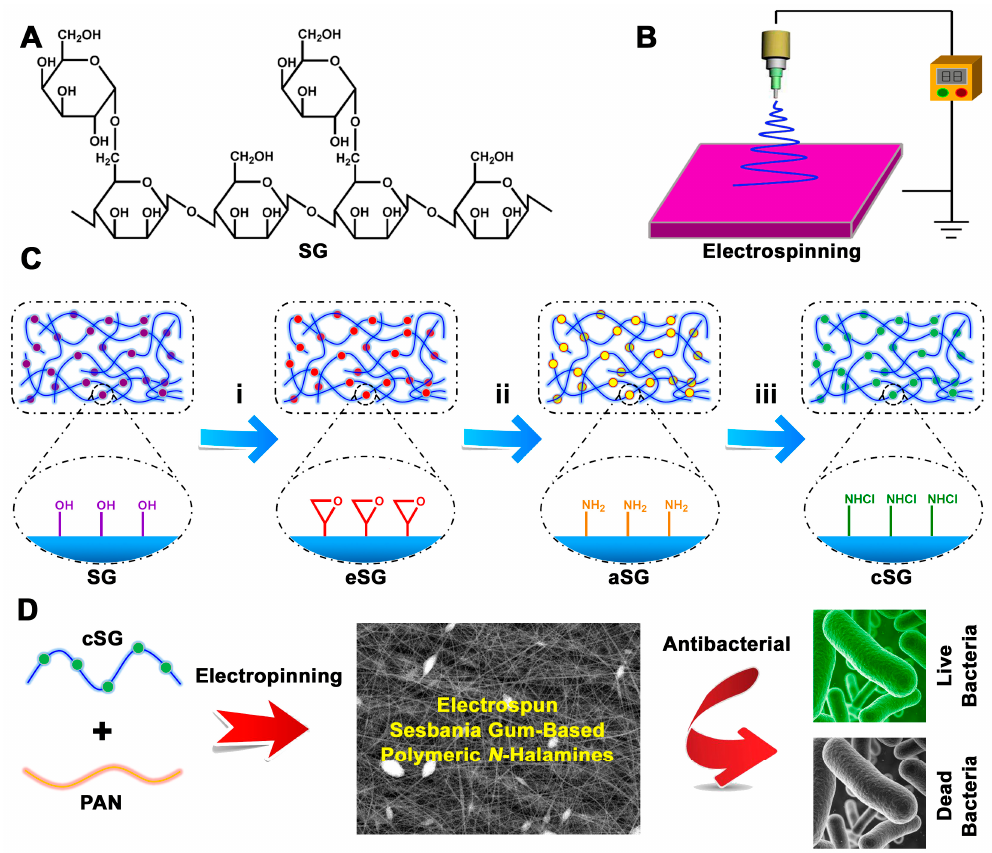
Figure 1. ( A ) Chemical structure of sesbania gum (SG). ( B ) Schematic diagram of the electrospinning device. ( C ) Schematic illustration of sesbania gum-based polymeric N -halamine. ( D ) Schematic depiction of the synthesis of SG-based polymeric N -halamines (cSG-PAN) using electrospinning and the antibacterial action of cSG-PAN.